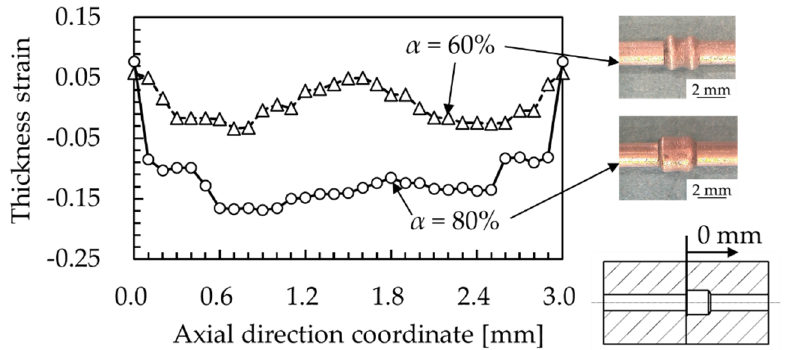
Figure 23. Thickness strain of the deformed tubes in the cylinder-shape warm THF at 250 °C.